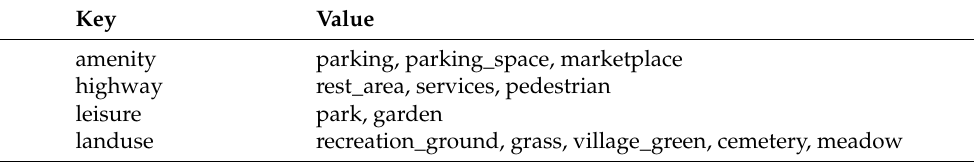
Figure 2. A sample street network in the city of Heidelberg, Germany, showing ( a ) how geo-tagged tweets were selected based on the buffer around the highways for the “User count on a road segment” proxy, and ( b ) how a geo-tagged tweet cluster in a public space was used for the “User count within a vicinity” proxy. Table 5. Public space POIs used for the User count within a vicinity proxy as defined in OSM (key–value pair). The right column provides the values used for the different OSM keys of this proxy. These key–value pairs cover spaces where people gather during various hours of the day or on special